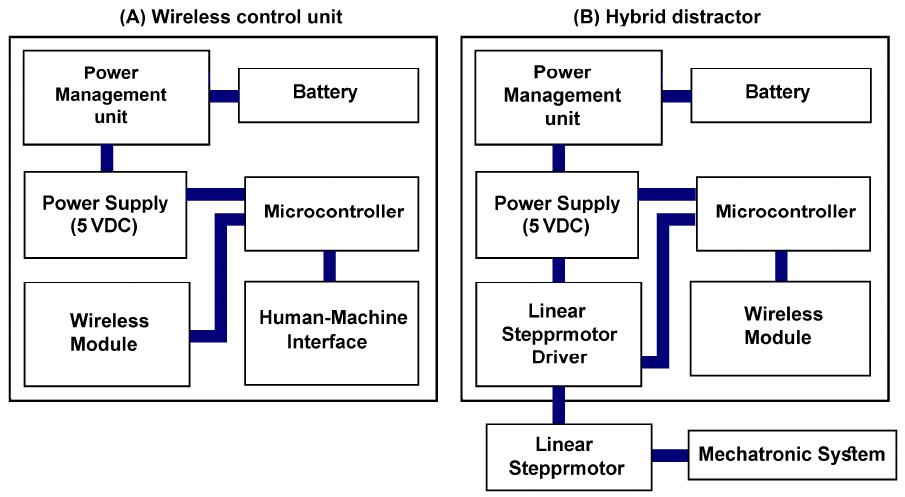
Figure 2. The block diagram of the